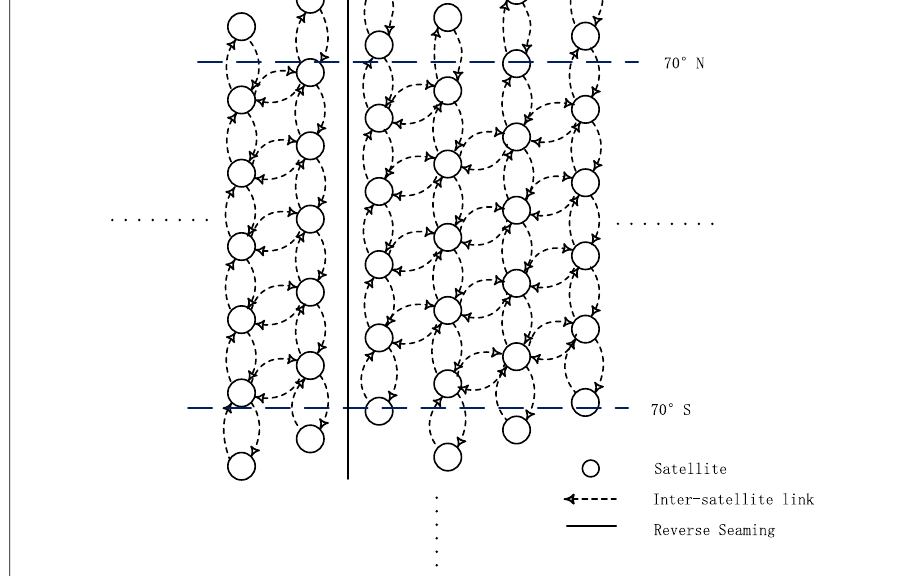
Fig. 2 Satellite constellation topology